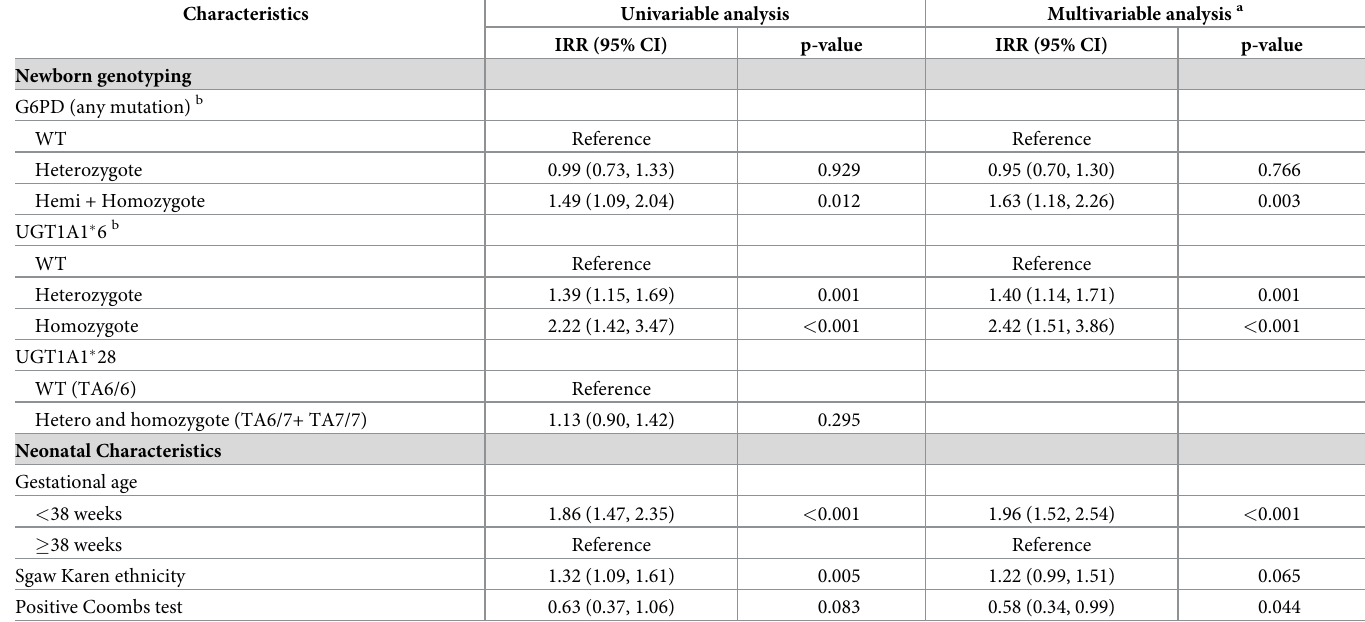
Table 6. Uni- and multivariable analysis of genetic factors and other significant risk factors for duration of prolonged jaundice using mixed effects negative bino- mial model clustering by site.